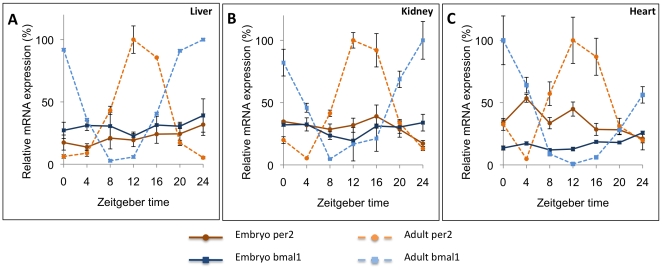
Twenty-four-hour expression profiles of Per2 and Bmal1 mRNA in embryonic (E18-E19) and adult tissues.mRNA levels of embryonic liver (A), kidney (B) and heart (C) collected every 4 hours, for 24 hours and mRNA was measured using quantitative real-time RT-PCR. Embryonic tissues showed little variation, especially in comparison to the robust changes seen in adult tissues. Adult liver is represented by the same maternal data shown in Figure 2C and by adult kidney and heart from 30-day old mice. RNA levels were normalized to the control gene, gapdh. Symbols represent the mean ± standard error of the mean (SEM) of three biological replicates. For each tissue the maximum adult value was set to 100 and the rest of adult and embryonic samples are presented relative to that maximum.